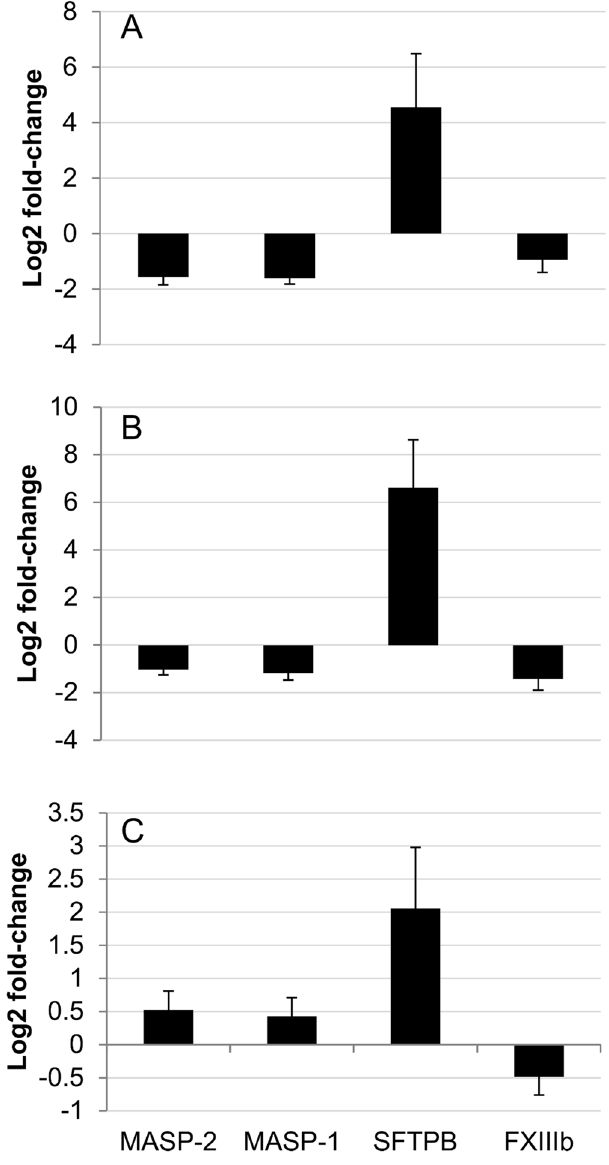
Figure 3. Average protein expression for 4 candidates across time points in PRM assay. Graphs depict log2 fold-changes of measured protein intensities, standard errors are indicated. ( A ) comparison day 34/day-7; ( B ) comparison day 75/day-7; ( C ) comparison day 75/day 34. Three proteins were found to be downregulated over the course of the infection in the main study (DIA experiments and analysis in Spectronaut and MSstat): MASP-1 and MASP-2 (F1PQ85 and F6USM4), and FXIII-B (F1Q041). The last protein, SFTPB (P17129), was upregulated over time in the main